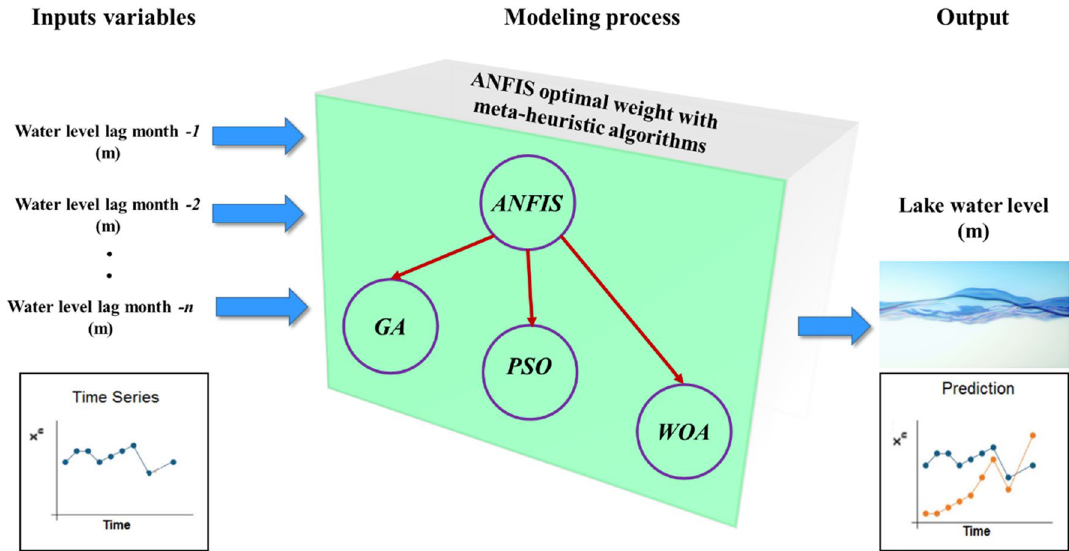
Fig. 4 Schematic view of predict lake level by ANFIS, ANFIS-GA, ANFIS-PSO, and ANFIS-WOA